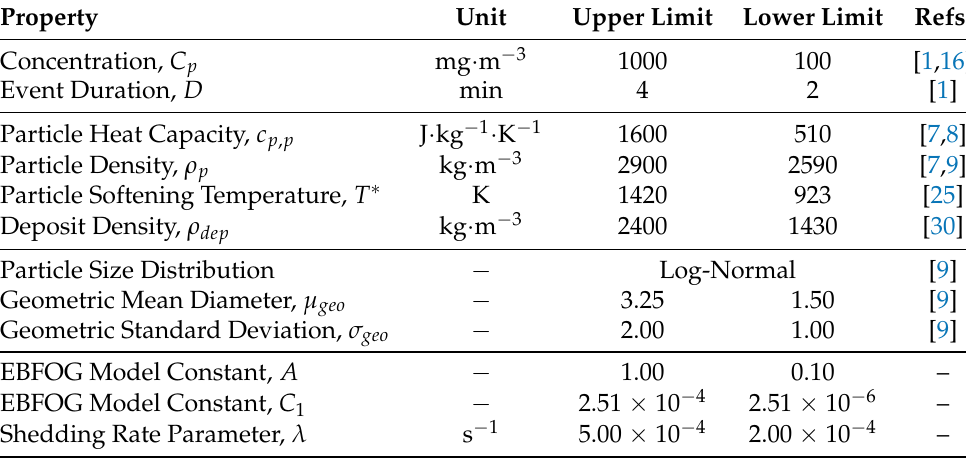
Table 1. Dust property ranges for the basaltic–andesite ash encountered during the 1982 Mount Galunggung encounter.